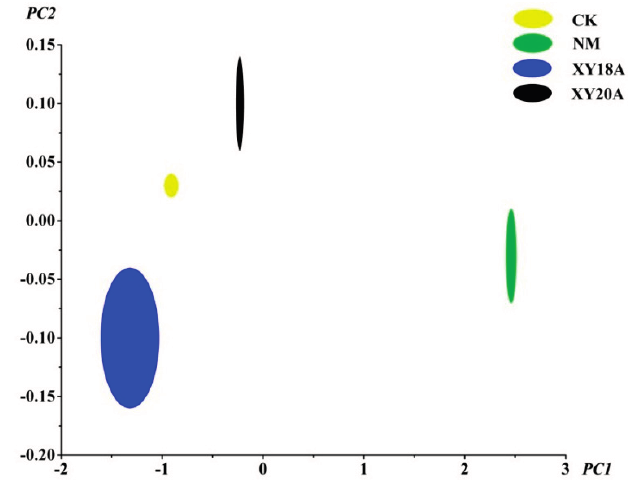
Figure 2. Plot of the first two principal components based on E-nose